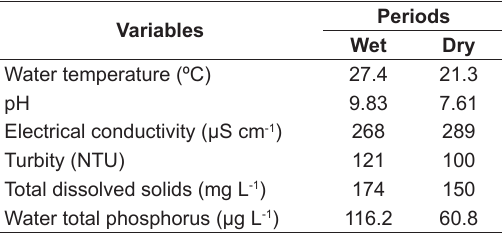
Table 1. Results of abiotic variables in the water (30 cm depth) at Garças Reservoir during wet and dry periods.